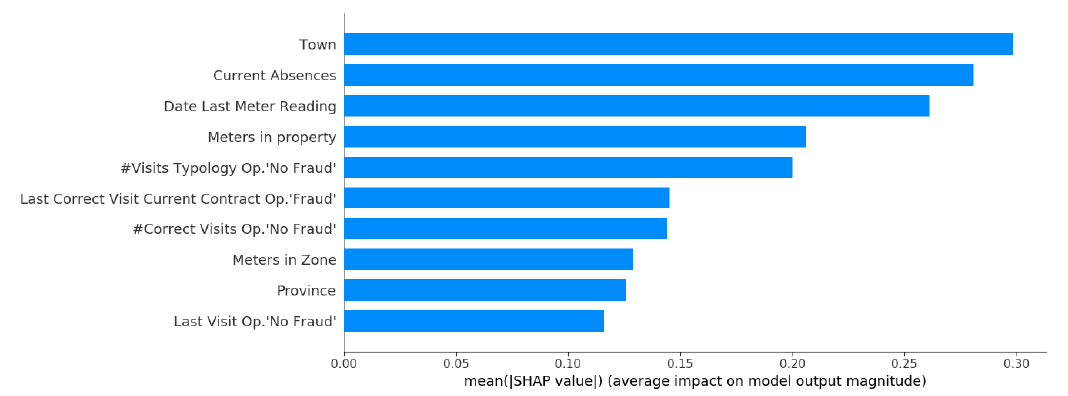
Figure 7. Real example of the 10 most important features according to SHAP despite the fact that we can see features that can be considered to be essential to detect fraud (e.g., those related to the visits); it is true that we are missing consumption-related features. A goal in our system is to reevaluate those features that we think that should be more important than what SHAP